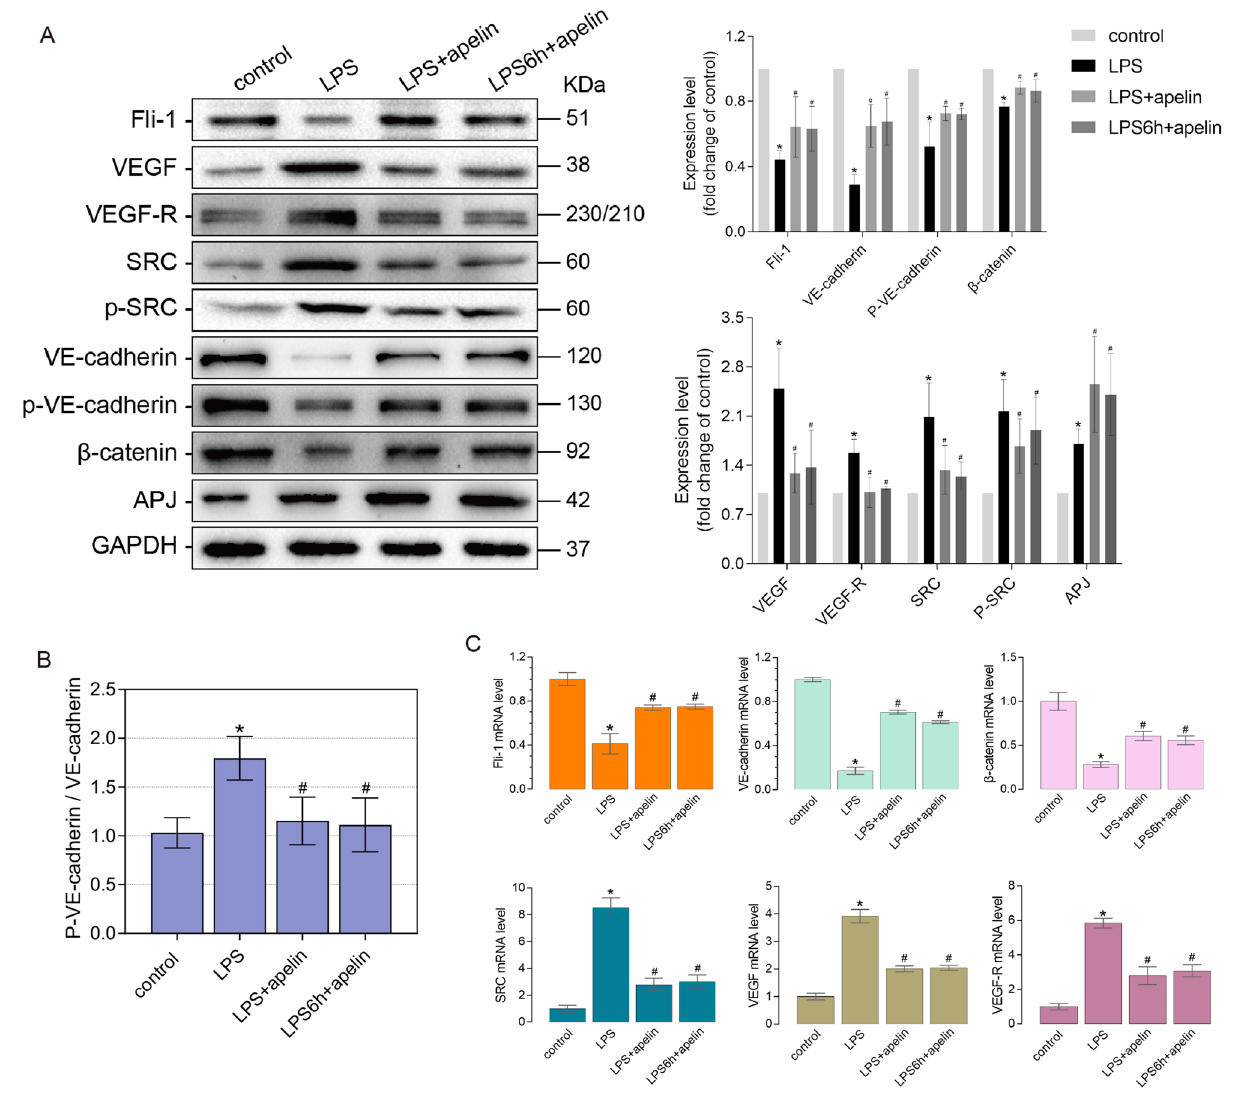
Figure 4. Effect of apelin prevention and treatment on related proteins and genes. ( A ) Changes in Fli-1, APJ and adherens junction-related proteins in lung tissue after prevention and treatment of ALI mice by apelin, detected by western blot (n = 3–4). The bar graphs represent the statistical results of the grayscale values of each group of proteins. ( B ) Effect of apelin prevention and treatment on VE-cadherin internalization (n = 4). ( C ) qRT-PCR detection of apelin on Fli-1 and adherens junction-related protein mRNA levels in lung tissue of ALI mice after prevention and treatment (n = 4). Data are presented as the mean ± SEM. *P < 0.05 vs. the control group, and # P < 0.05 vs. the LPS